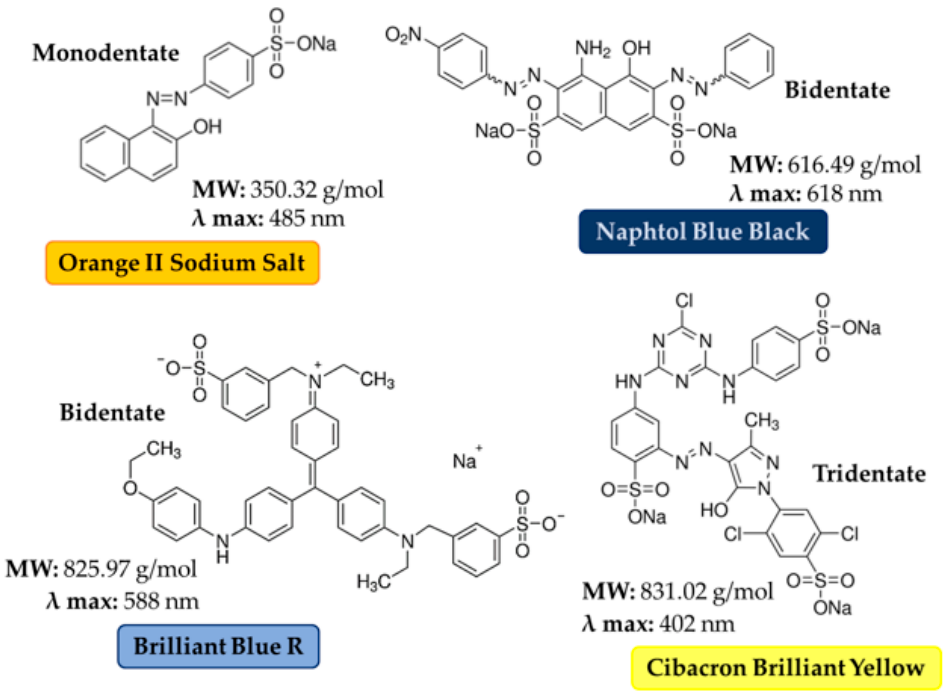
Table 1. Values of initial concentrations (C 0 ) and sponge quantities (m) for kinetic tests, where the solution volume was 25 mL. The same C 0 values are also used for comparison tests between cellulose nanosponges (CNS) and activated carbon (Section